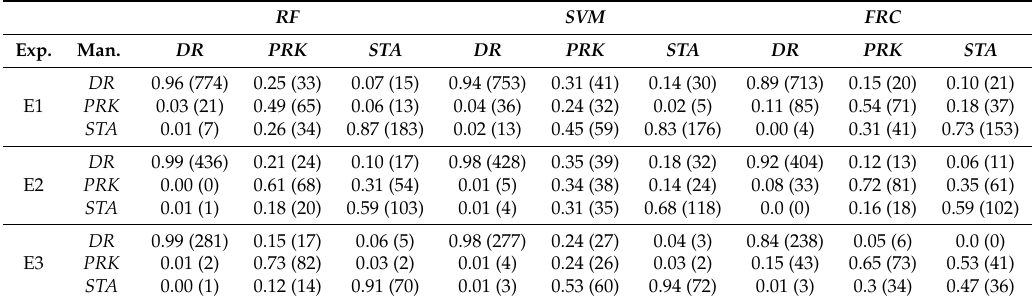
Table 7. Confusion matrix of the candidates when acting as a fine-grained classifier in terms of percentage and number (in brackets) of correctly-classified instances. RF SVM FRC Exp. Man.